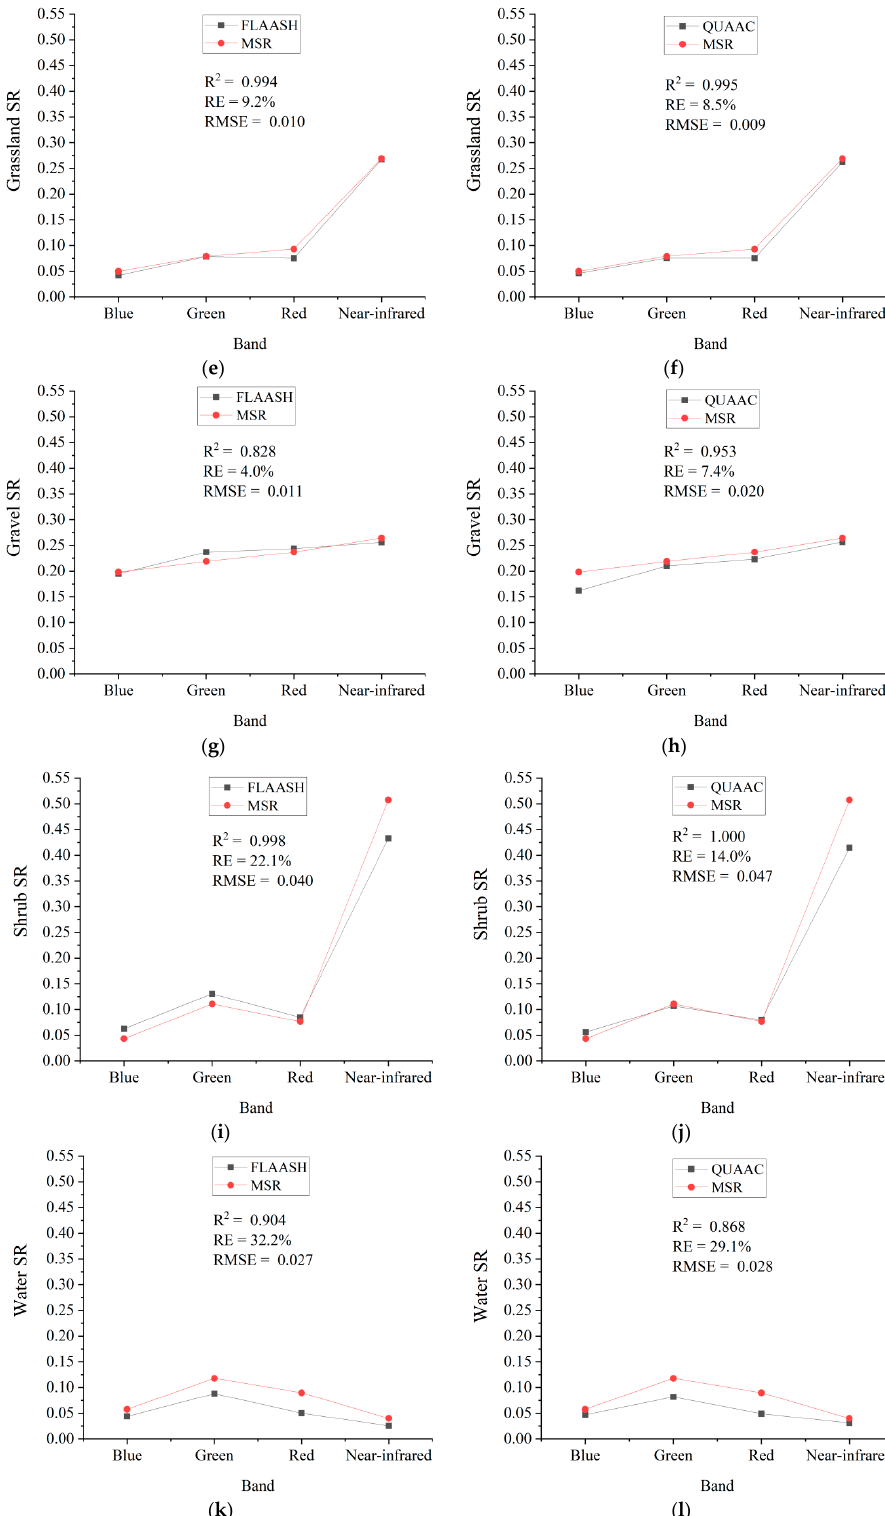
Figure 5. Comparison of QUAAC (right column) and FLAASH (left column) corrected spectral reflectances versus synchronized MSR on each surface type. From top to bottom, they are the concrete floor of Dongting Lake on 11 November 2020 ( a , b ), the soil of Dongting Lake on 15 January 2021 ( c , d ), the grassland of Xilinhot on 27 June 2020 ( e , f ), the gravel of Qiyang on 3 September 2021 ( g , h ), the shrub of Qiyang on 6 July and 2021 ( i , j ), the water of Guangzhou on 29 January 2021 ( k , l ). Each subfigure is marked with R 2 , RE, and RMS.